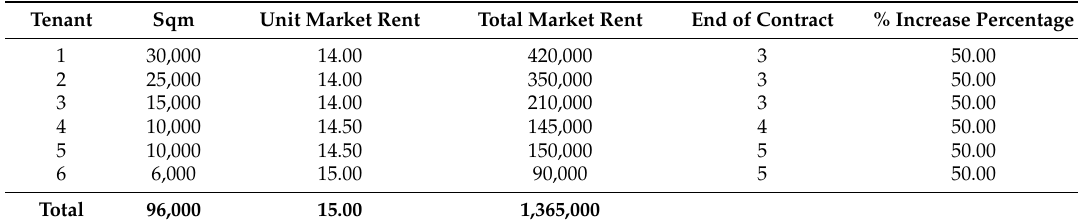
Table 2. Main information relating to each